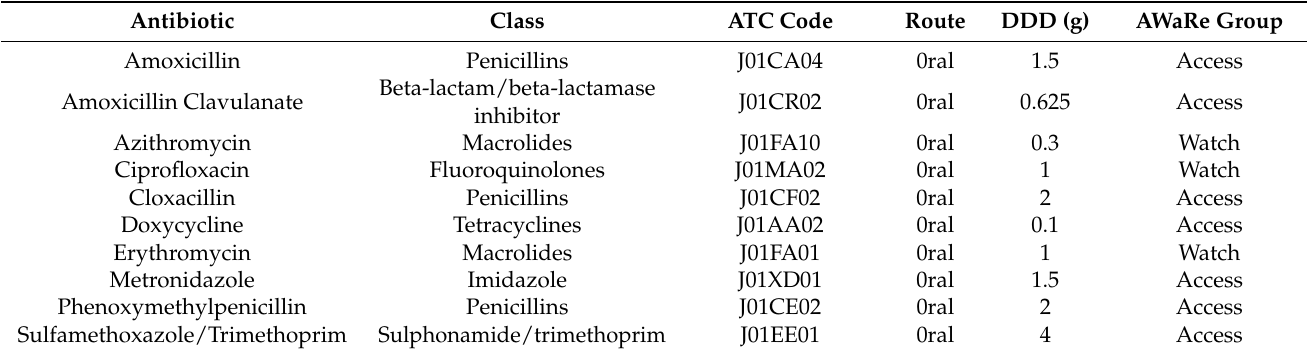
Table 1. Antibiotics for systemic use (J01) consumed by inpatients and outpatients at VCH, Vanu- atu 2018 to 2021 with ATC code, route of administration, DDD units in grams obtained from the ATC/DDD index 2022 and Access, Watch and Reserve